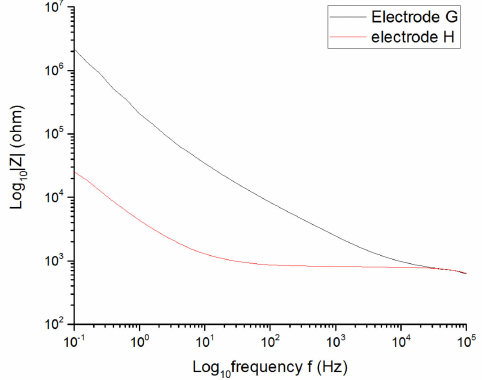
Figure 10. Increase of the CSC c because of a higher roughness factor.